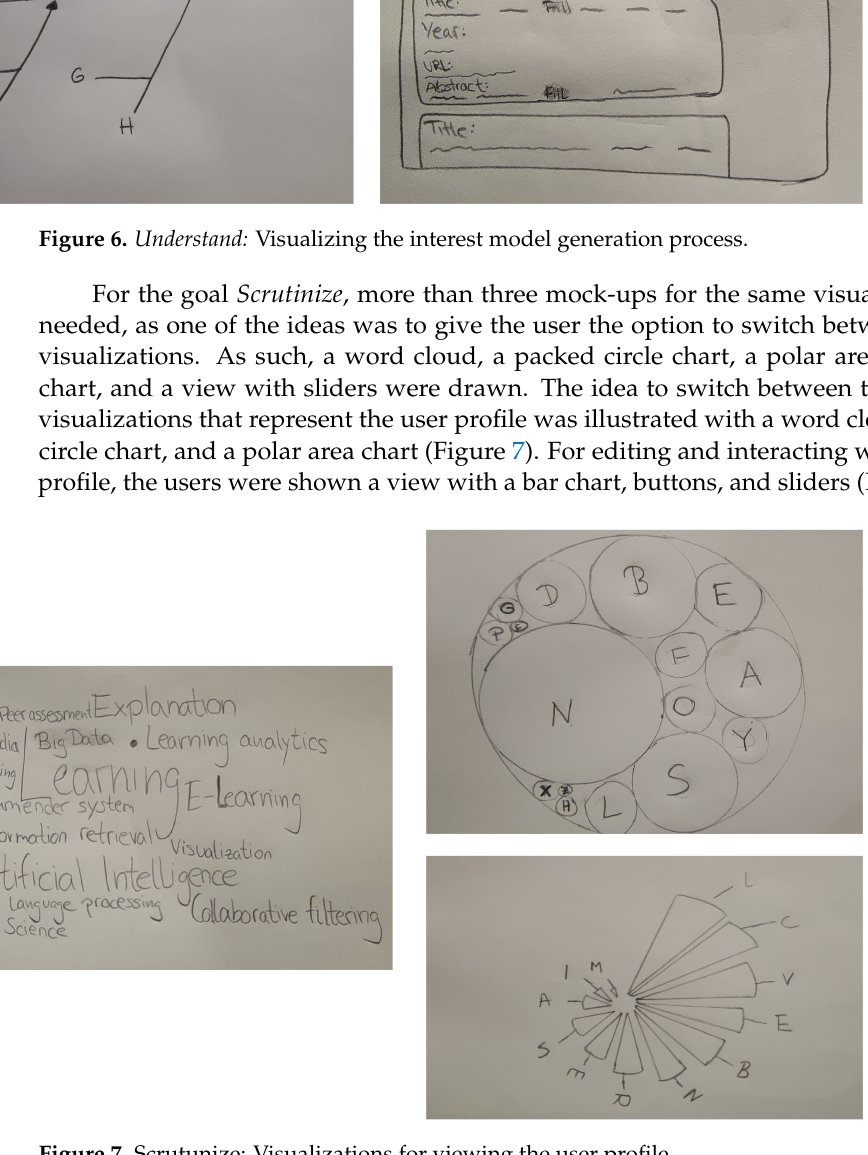
Figure 7. Scrutunize: Visualizations for viewing the user